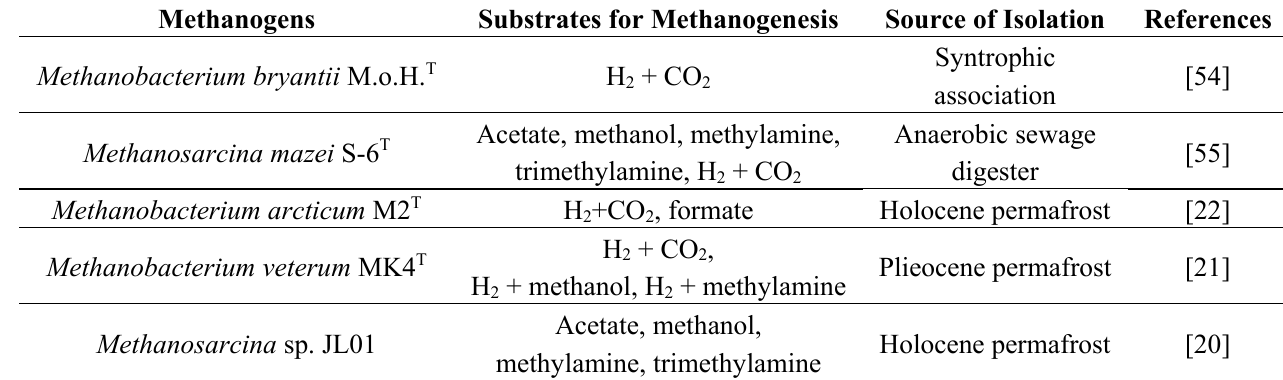
Table 1. Characteristics of methanogenic archaea used in the